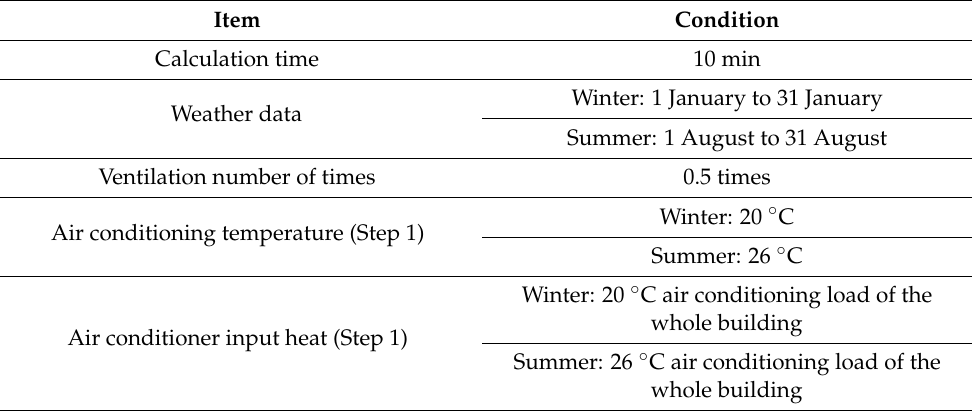
Table 5. THERB calculation